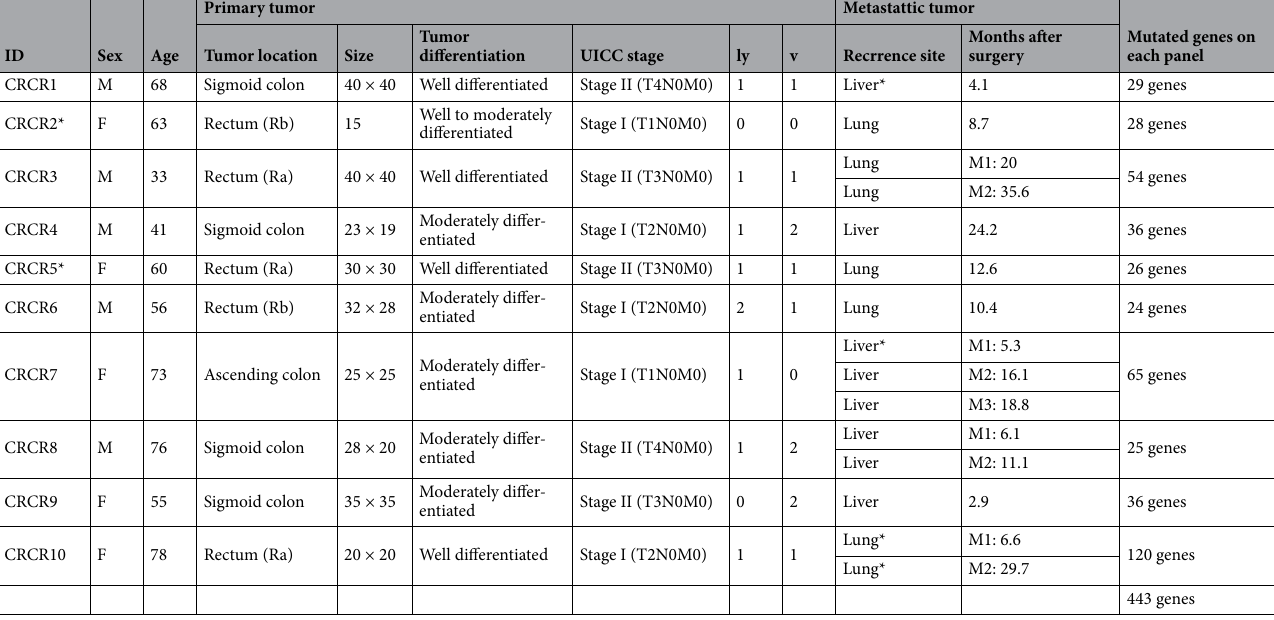
Table 1. Information of 10 cases of colorectal cancer with recurrence (CRCR). We excluded CRCR2, CRCR3, CRCR6 and CRCR10 from further analysis, because of inadequate amount of plasma samples. *No RNA Sequence data in 2 primary and 4 metastatic